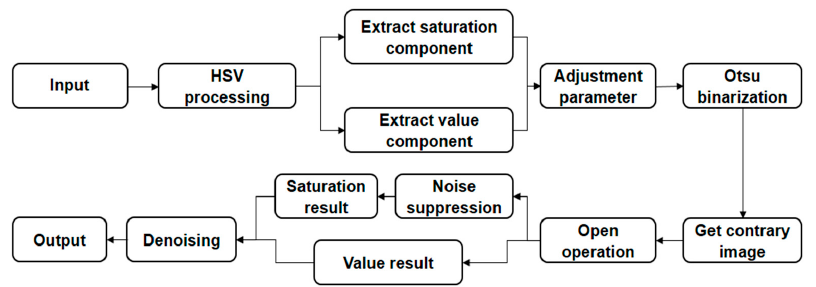
Figure 2. Algorithm flowchart.